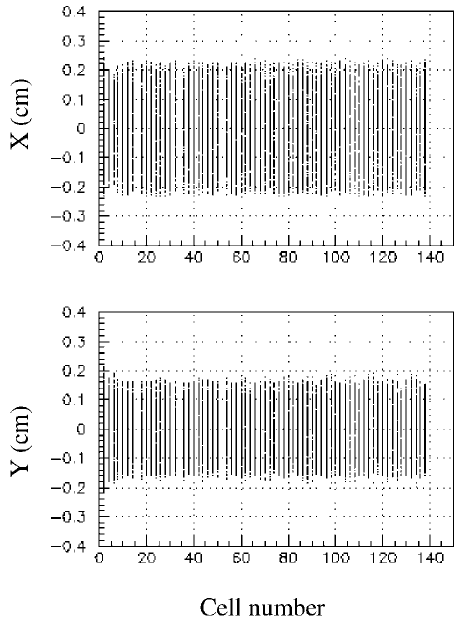
FIG. 8. (Color) Particle distributions in the transverse planes along the